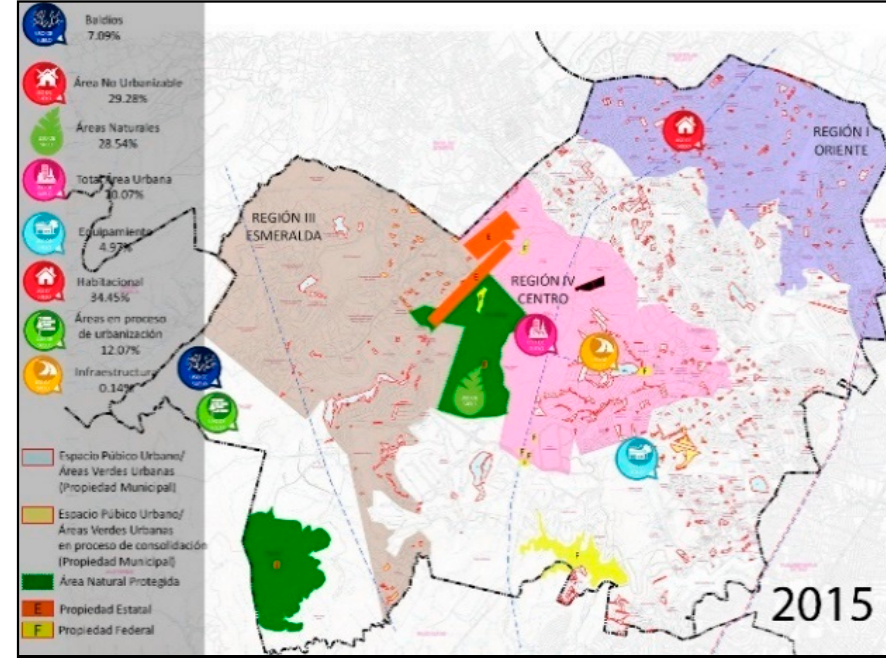
Figure 4. Land uses in Atizapán de Zaragoza (figure by authors, with data from PMDU 2015 [44], Google maps, and field survey).